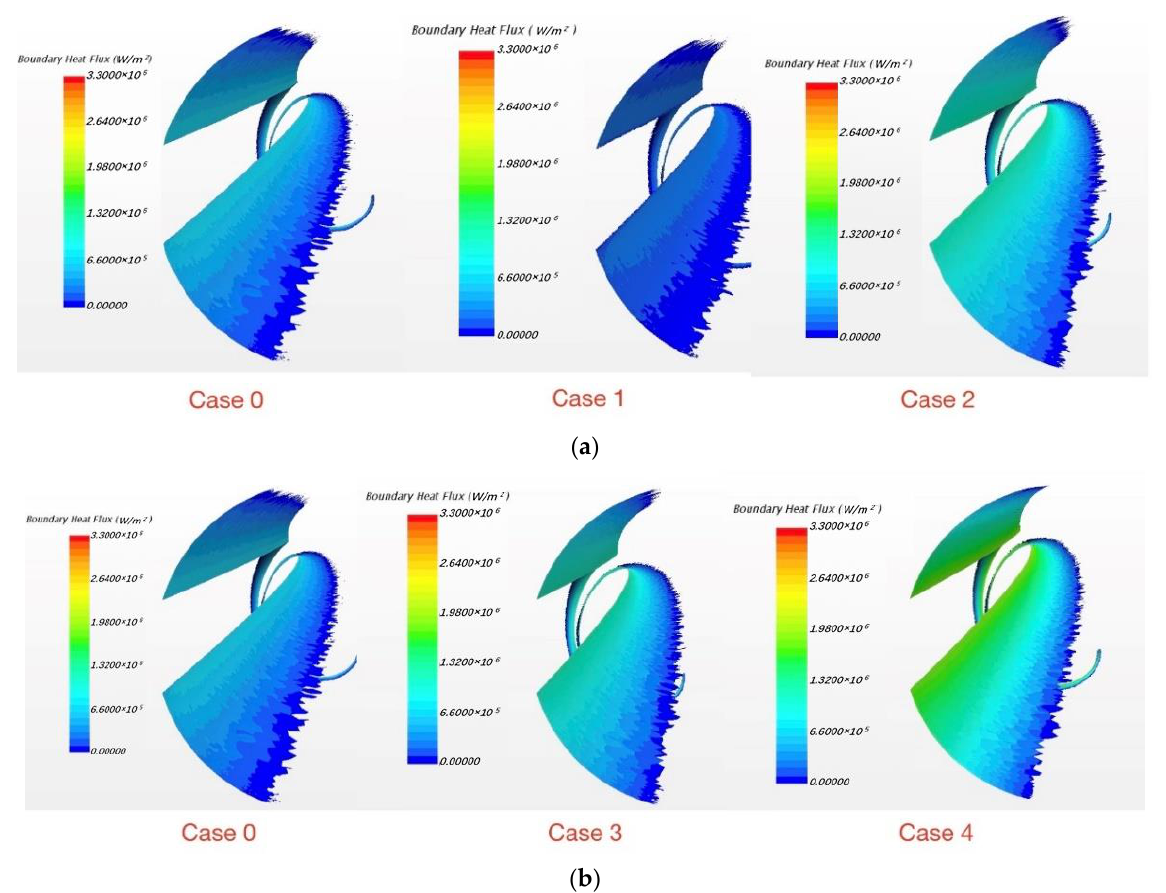
Figure 22. Physical property variation: ( a ) Thermal conductivity changes of sodium; ( b ) thermal conductivity changes of Ti316 alloy.